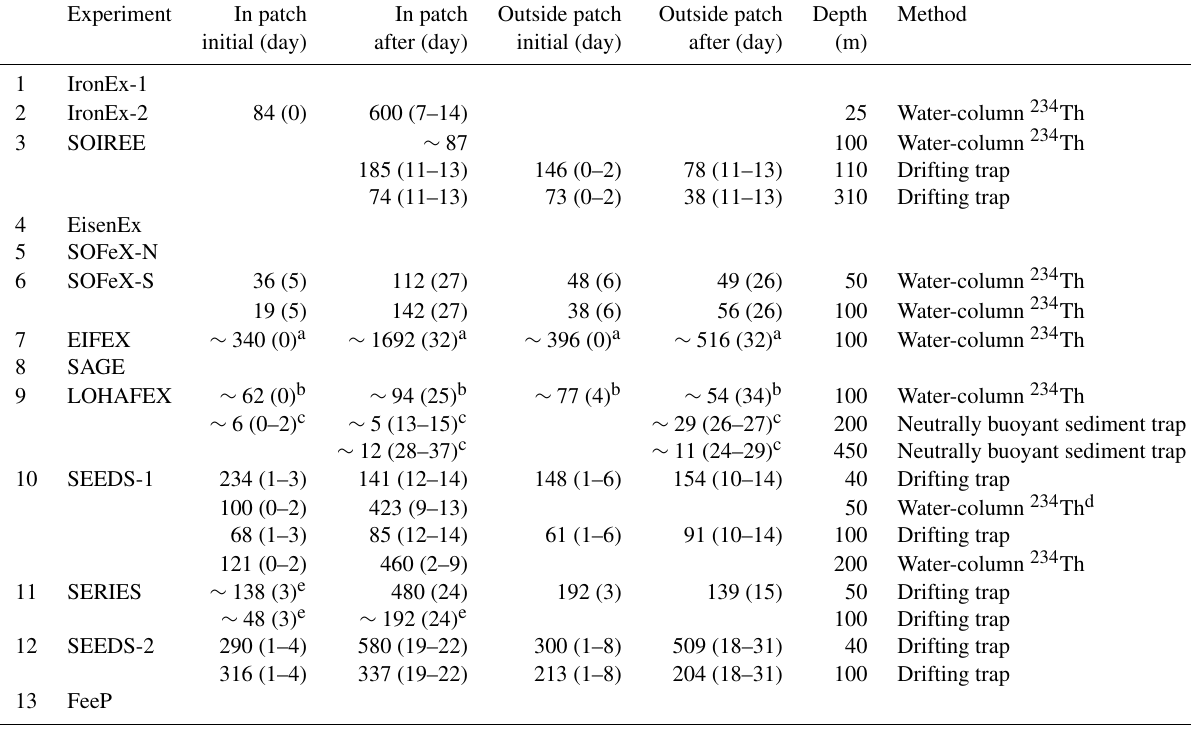
Table 5. Initial values of the export flux and the values after fertilization (mgCm − 2 day − 1 ), the corresponding depth inside and outside the fertilized patch for artificial ocean iron fertilization (aOIF) experiments, and measurement method. Values in brackets correspond to the day of measurement after